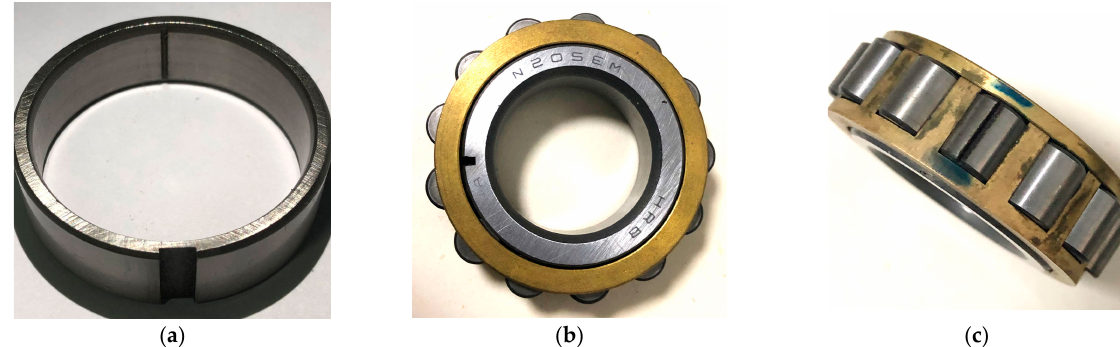
Figure 3. Test rig. Figure 3. Test rig.